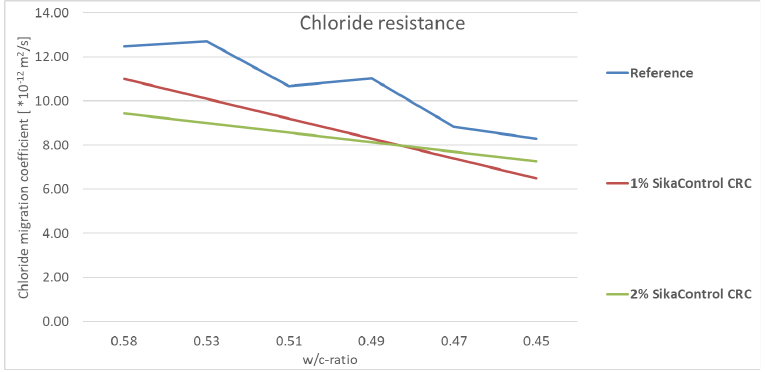
Figure 11. Reference concrete with various w/c-ratios: Chloride